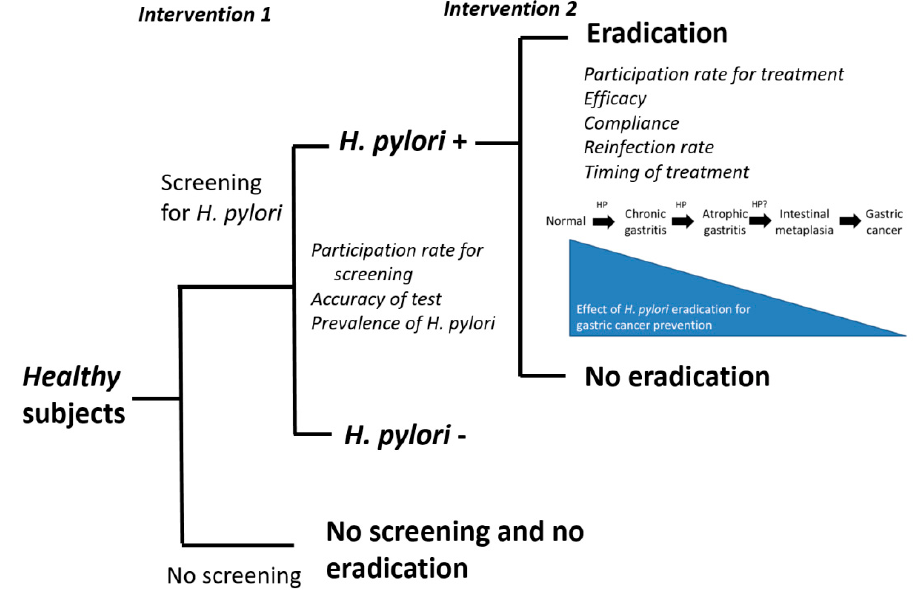
Figure 3. Factors affecting the efficacy of the strategy of screening and eradication of H. pylori for gastric cancer prevention. H. pylori: Helicobacter pylori ; HP: Helicobacter pylori . cancer prevention. H. pylori : Helicobacter pylori ; HP: Helicobacter pylori